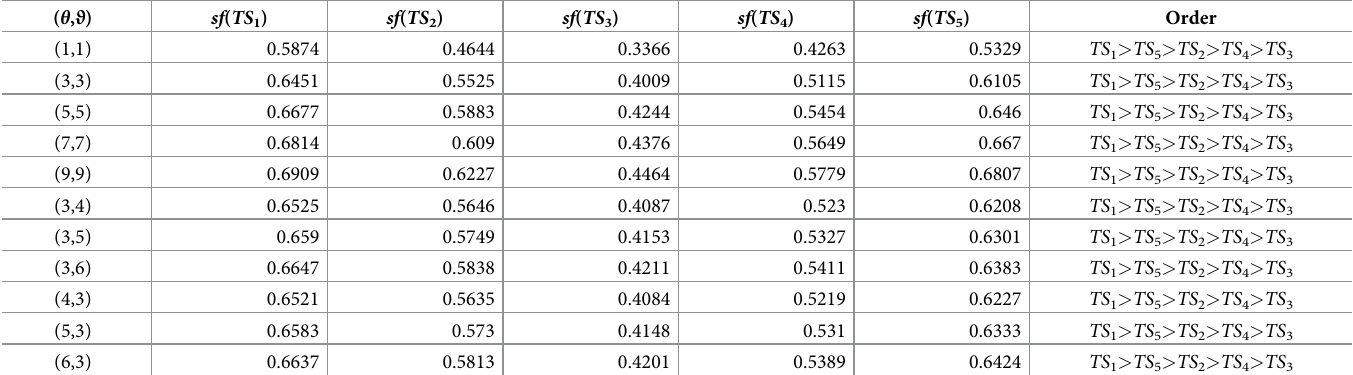
Table 5. Ranking results for different operational parameters of the G2TLNPHM